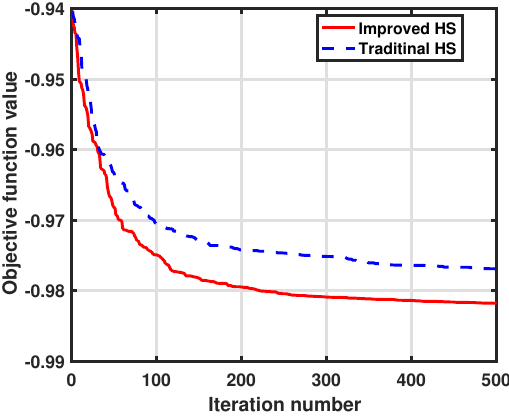
Figure 5. Convergence progress of objective function value with different HS